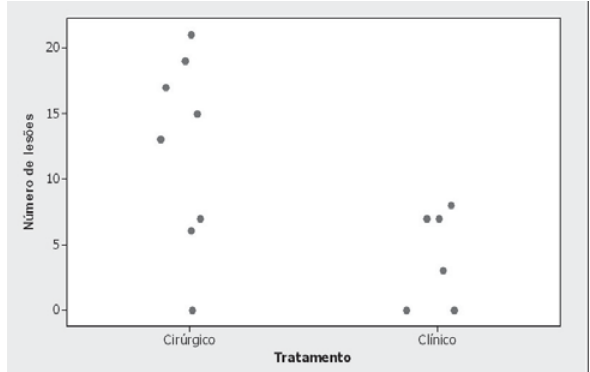
Fig. 6 - Gráfico de dispersão dos valores individuais relativos ao número de lesões conforme o tratamento cirúrgico (grupo B) e clínico (grupo A) para fechamento do ducto